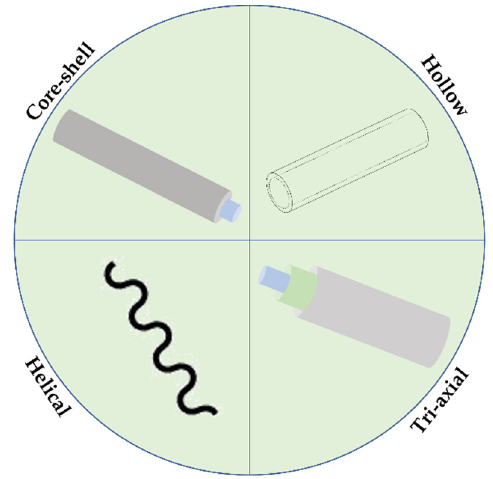
Figure 7. Schematic representation of the most common wet-spun fibers structural organizations.